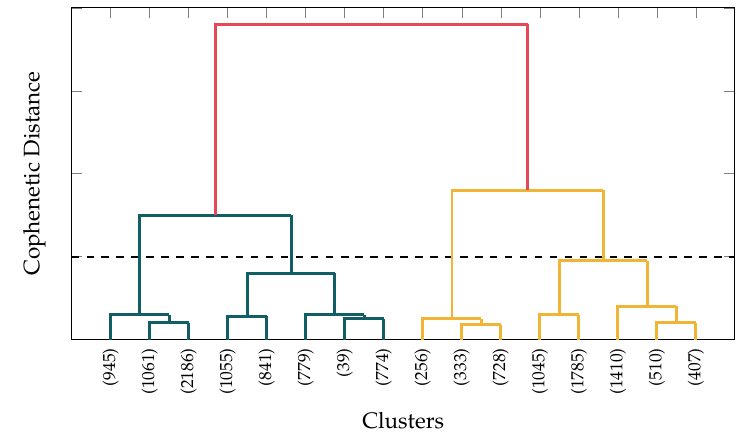
Figure 8. Hierarchical clustering dendrogram for a scenario with a data rate of 50 Mbps and 50